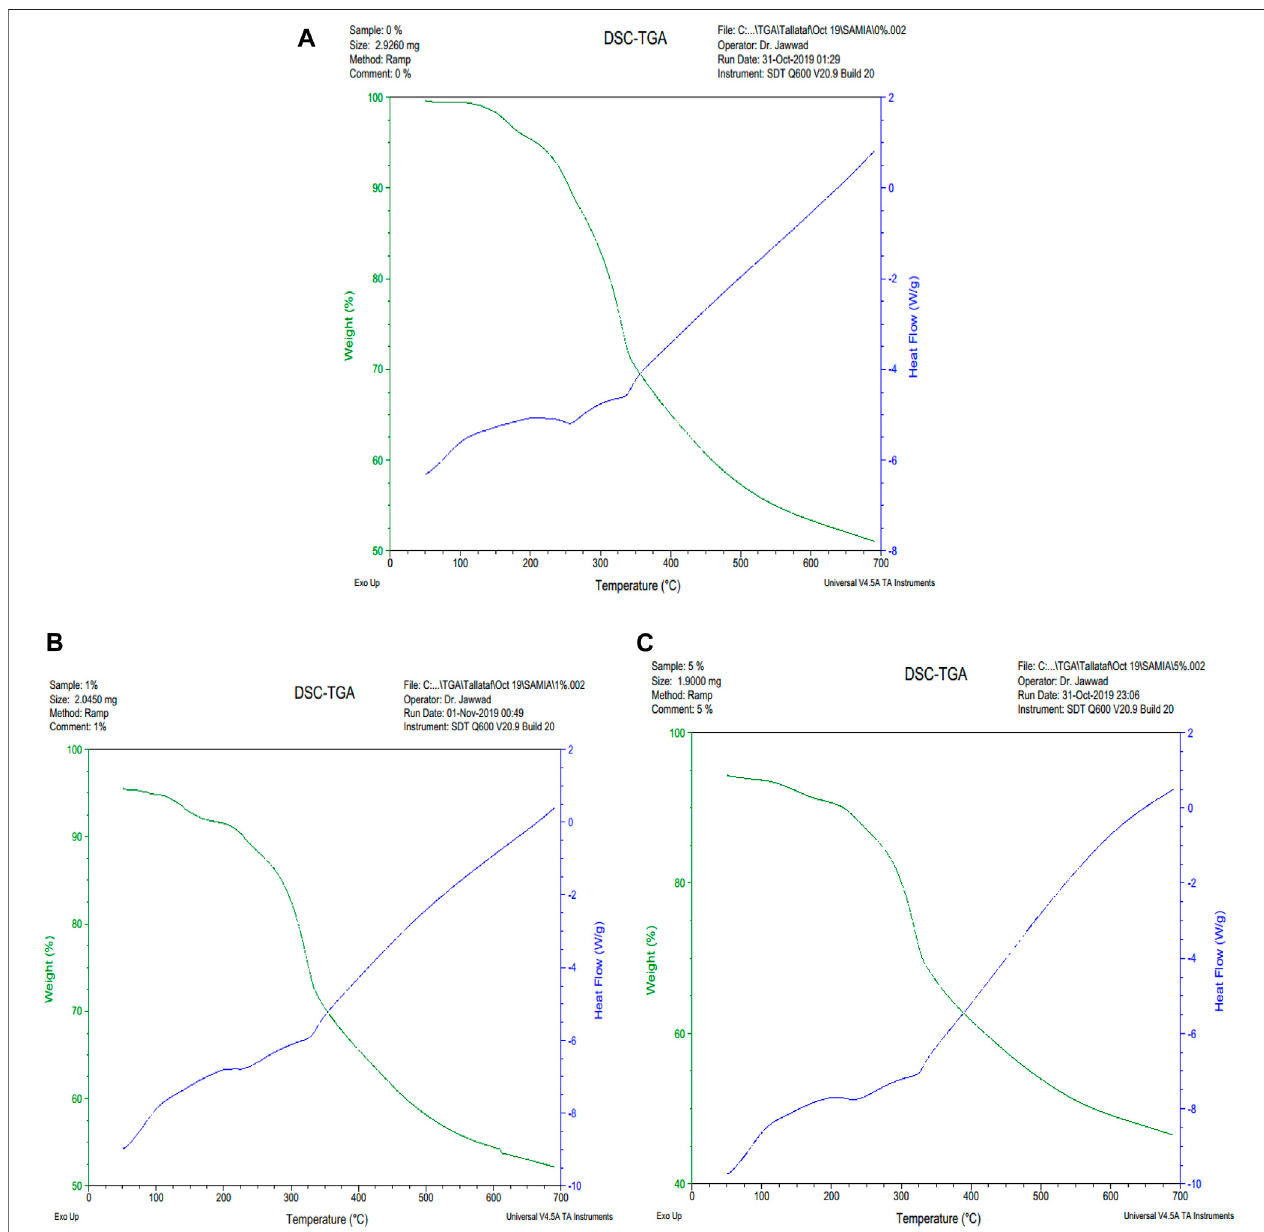
FIGURE 7 | DSC – TGA of (A) pure POC, (B) POC/MMT 1%, and (C) POC/MMT